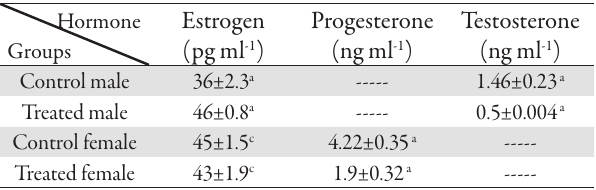
Tab. 5. Effect of Salvadora persica aqueous extract on sex ho rmones levels in serum of male and female rat treated